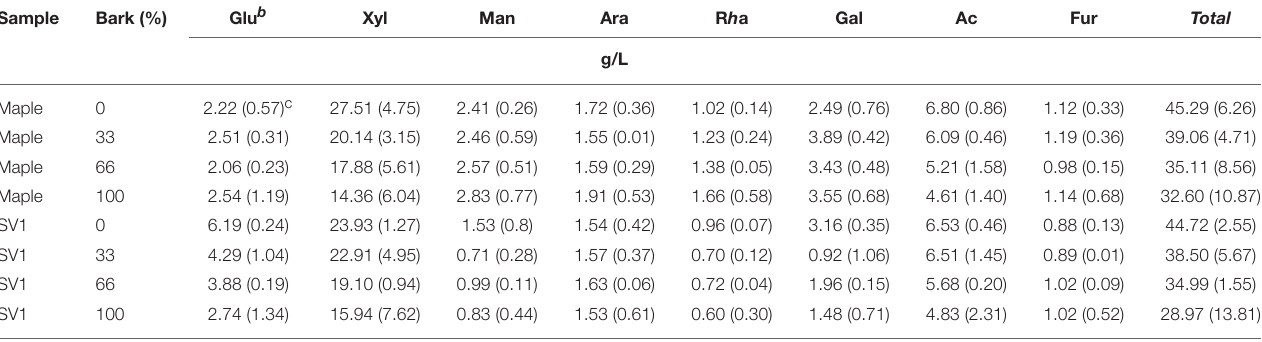
TABLE 2 | Chemical concentrations of the hydrolyzate a . Sample